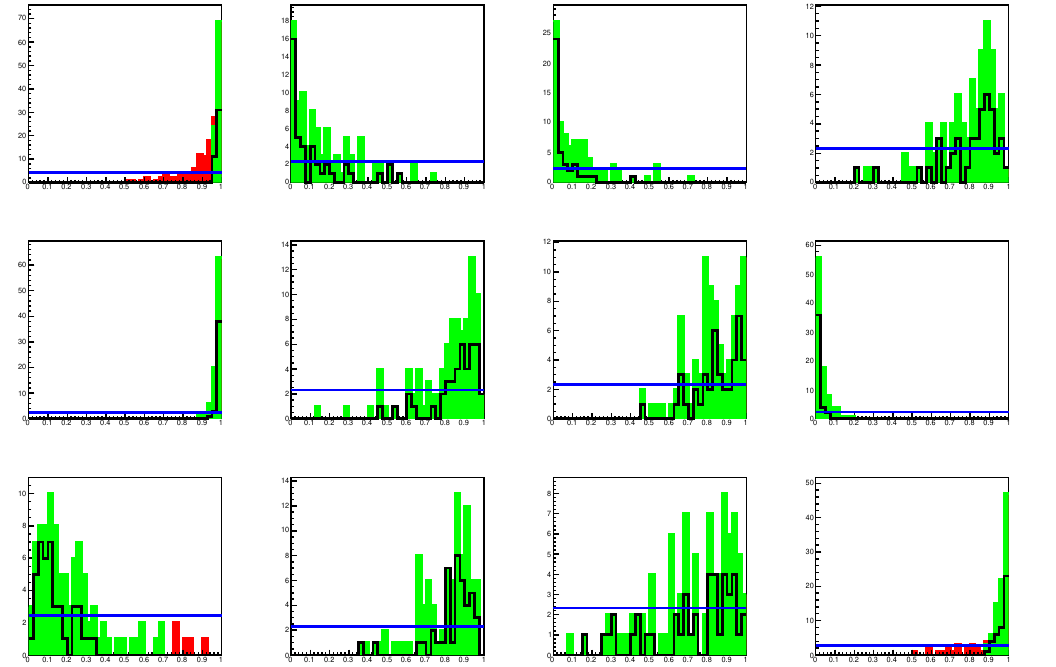
Figure 16 . Marginal distributions in the copula space for features defining the subspace where the best box is found by RanBoxIter on MiniBooNE data, for test 14 in table 8: the 12 features defining the subspace are shown for all data (blue empty histogram), for data in the best box (green), for data failing only a selection on the variable displayed (red), and for signal events in the box (black empty histogram with thick line). All distributions are normalized to unit area.